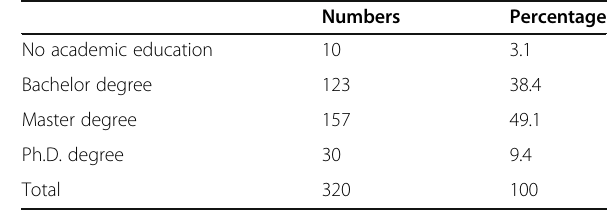
Table 10 The number and percentage of respondents by age group Table 11 The number and percentage of participants according to the level of